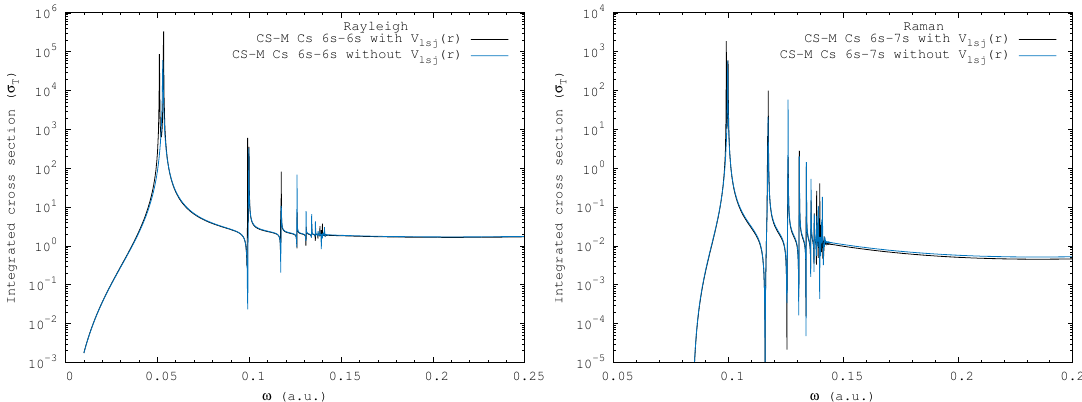
Figure 3. Rayleigh and Raman scattering cross sections for the ground state of cesium with and without spin-orbit interaction. These cross sections were calculated with the CS method using the modified length form of the dipole